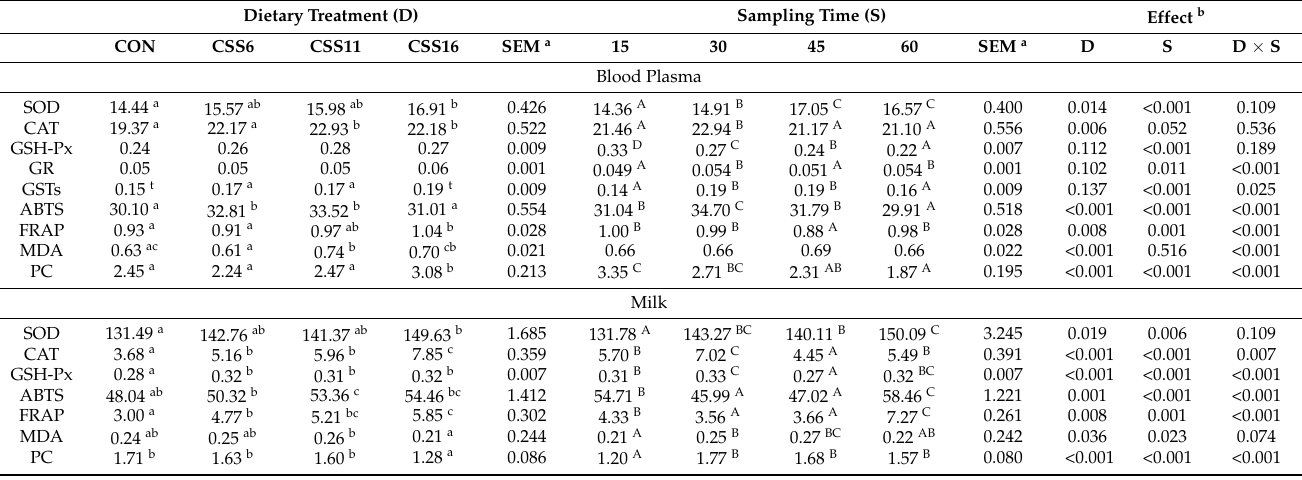
Table 5. Enzyme activities (Units/mL), total antioxidant capacity, and oxidative status biomarkers in blood plasma and milk of ewes fed diets (CON, CSS6, CSS11, CSS16) with different levels of Camelina seeds (6%, 11%, and 16% of concentrate) throughout the experimental period (15th, 30th, 45th, and 60th experimental days). Dietary Treatment (D) Sampling Time